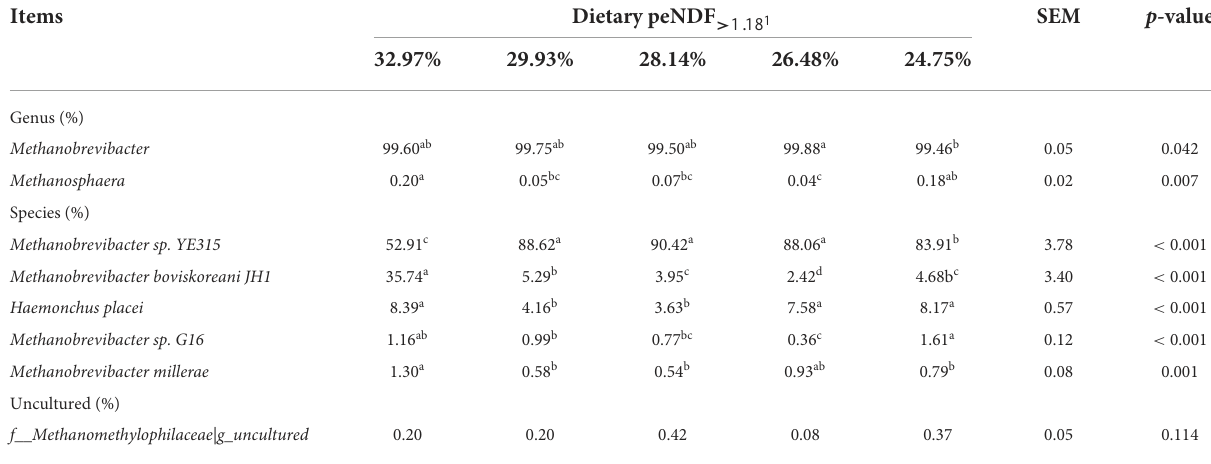
TABLE 7 Effects of different contents of peNDF > 1.18 in diets on rumen archaea abundance in